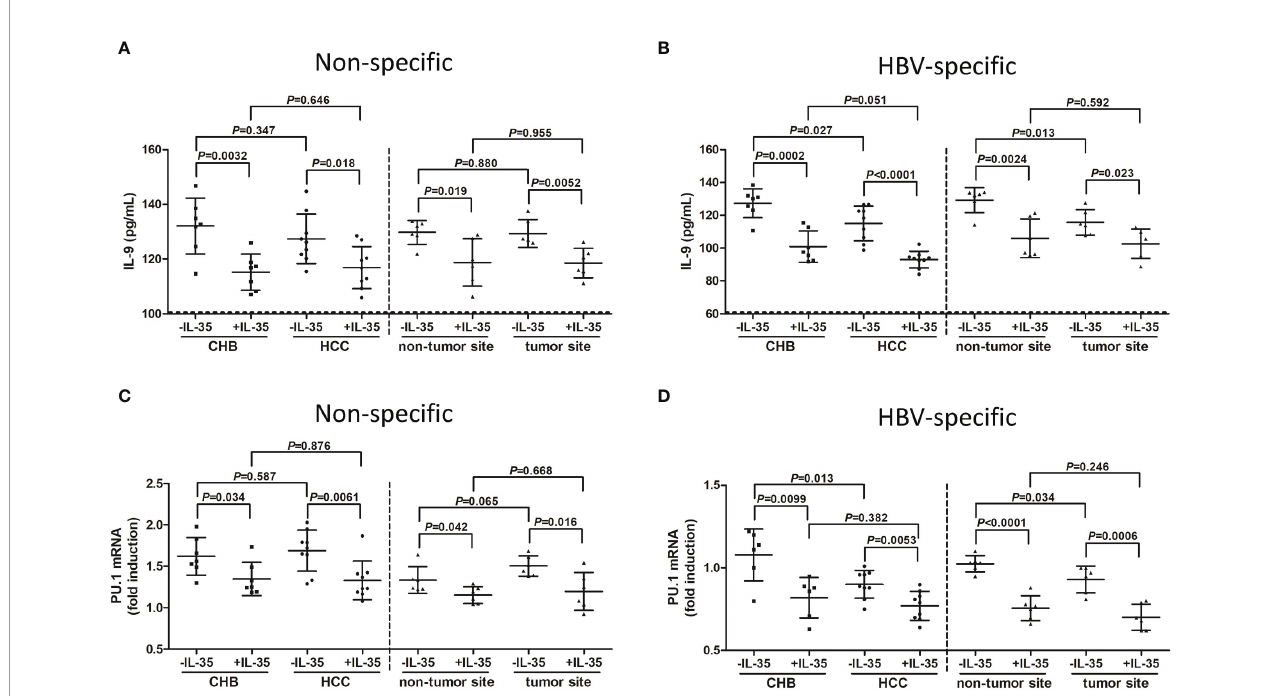
FIGURE 6 | In fl uence of recombinant IL-35 to non-speci fi c and HBV-speci fi c Th9 cells in hepatitis B-related hepatocellular carcinoma (HCC). CD4 + CXCR3 - CCR4 - CCR6 - cells were puri fi ed from peripheral blood mononuclear cells (PBMCs) of chronic hepatitis B (CHB) patients ( n =7) and hepatitis B-related HCC patients ( n =9), as well as from intrahepatic lymphocytes (IHLs) of fresh HCC specimens and non-tumor site liver specimens in HCC patients ( n =6). 10 4 of CD4 + CXCR3 - CCR4 - CCR6 - cells were stimulated with either anti-CD3/CD28 (1 m g/mL) or HBsAg (10 m g/mL) in the presence or absence of recombinant IL-35 (1 ng/mL) for 24 hours. Supernatants and cells were harvested. IL-9 level in the supernatants was measured by ELISA, while PU.1 mRNA expression in Th9 cells was quanti fi ed by real-time PCR. (A) IL-9 secretion by non-speci fi c Th9 cells was compared among groups with or without IL-35 stimulation. Signi fi cance was assessed using one-way ANOVA and SNK- q test. (B) IL-9 secretion by HBV-speci fi c Th9 cells was compared among groups with or without IL-35 stimulation. Signi fi cance was assessed using one- way ANOVA and SNK- q test. (C) PU.1 mRNA expression in non-speci fi c Th9 cells was compared among groups with or without IL-35 stimulation. Signi fi cance was assessed using one-way ANOVA and SNK- q test. (D) PU.1 mRNA expression in HBV-speci fi c Th9 cells was compared among groups with or without IL-35 stimulation. The dotted line presented lower detection limit for IL-9 (3.9 pg/mL). Signi fi cance was assessed using one-way ANOVA and SNK- q